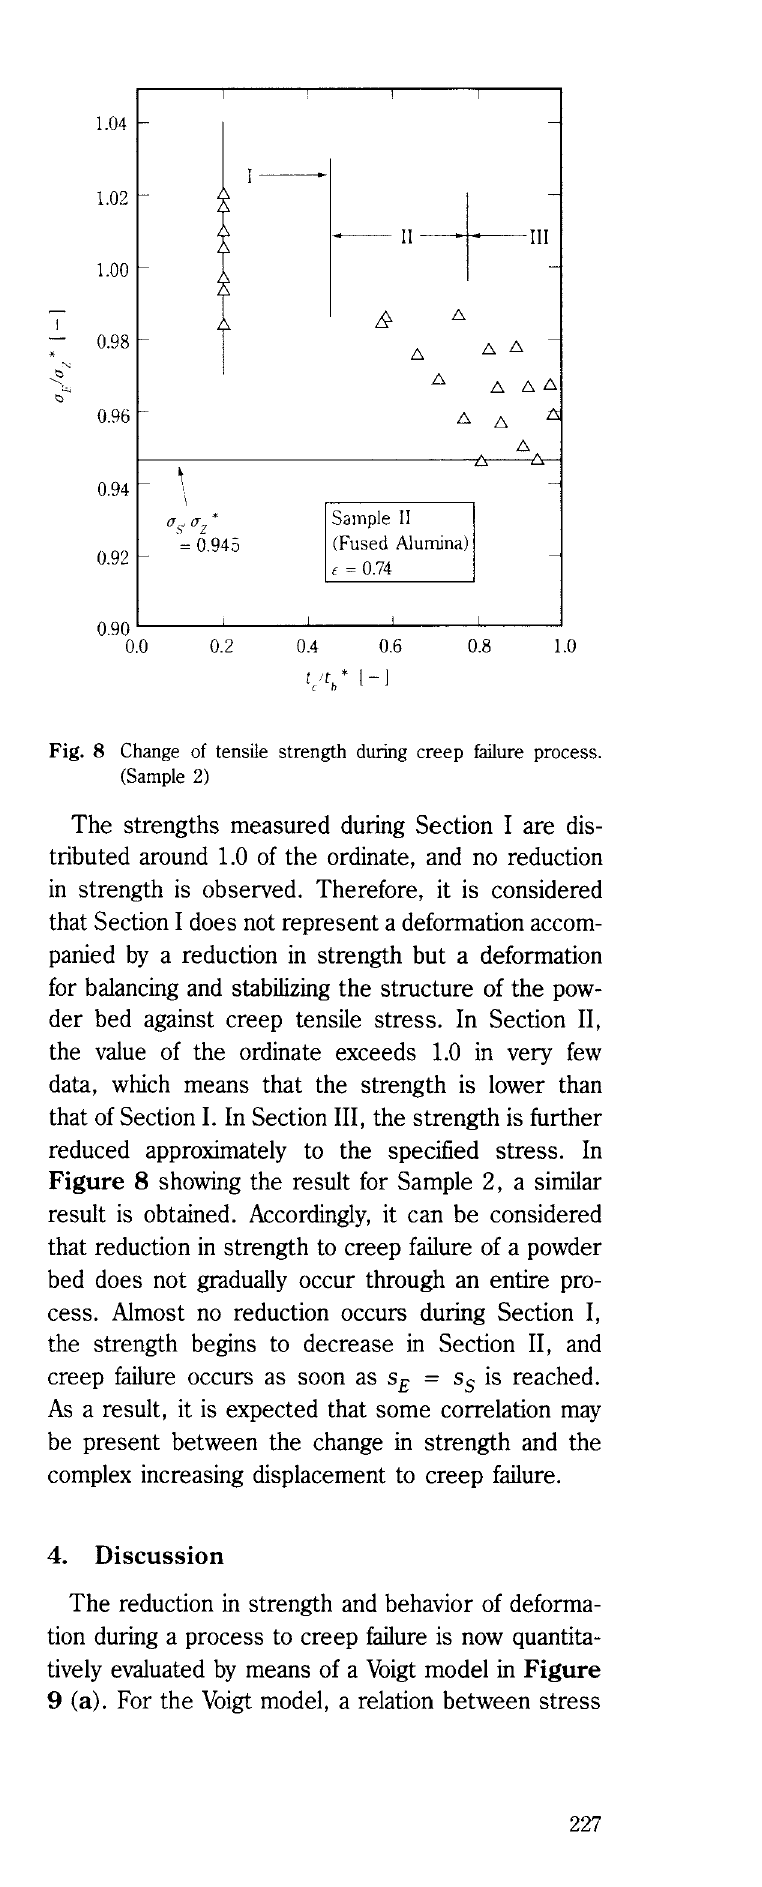
Fig. 7 Change of tensile strength during creep failure process. (Sample 1)